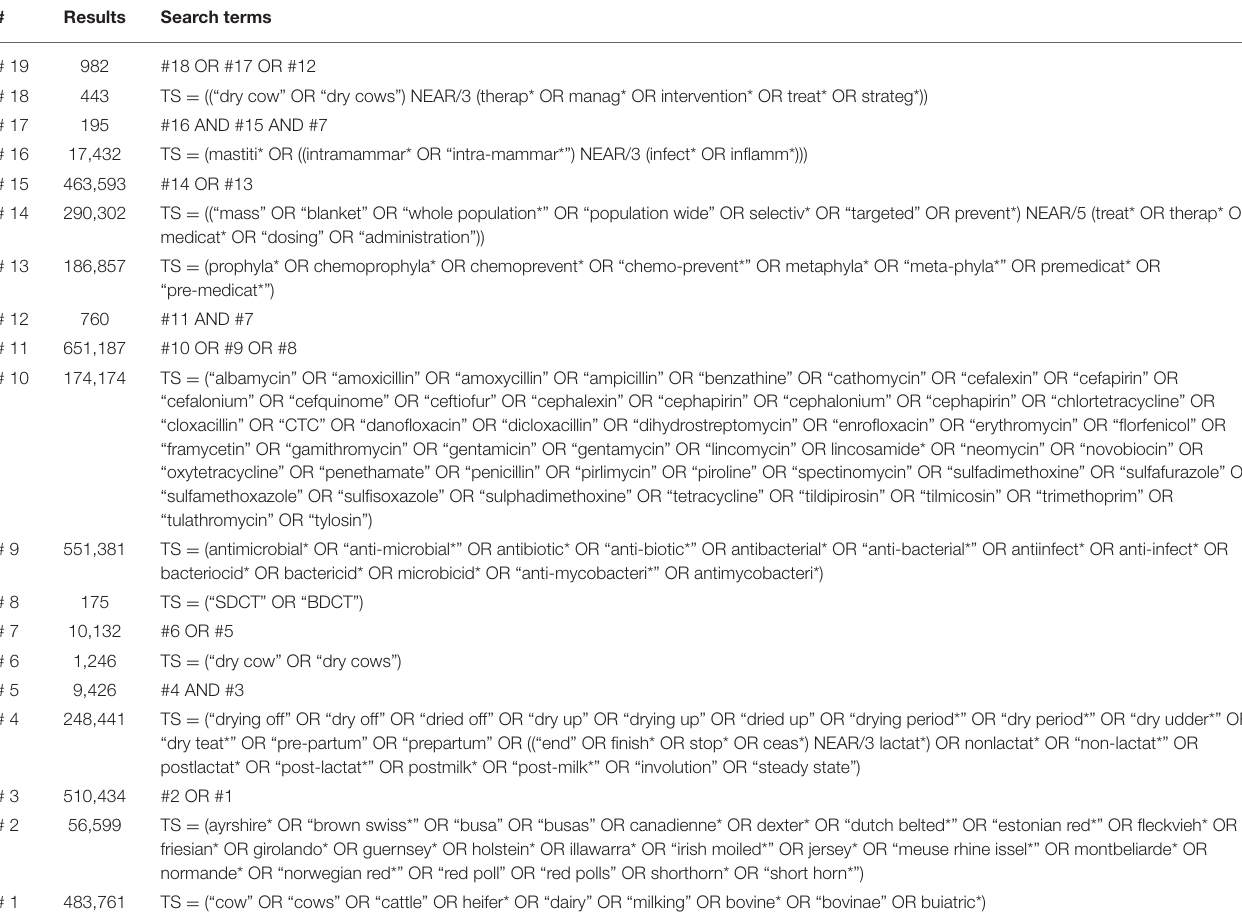
TABLE 1 | Search strategy to identify the relevant articles for the network meta-analysis assessing the relative efficacy of antimicrobial treatment protocols to cure existing intramammary infections (IMI) during the dry period in dairy cattle, conducted on June 14, 2019, in Science Citation Index (Web of